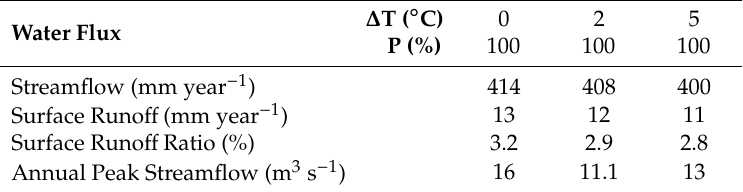
Table 5. Mean annual catchment scale water fluxes (falsified model) for the selected climate change